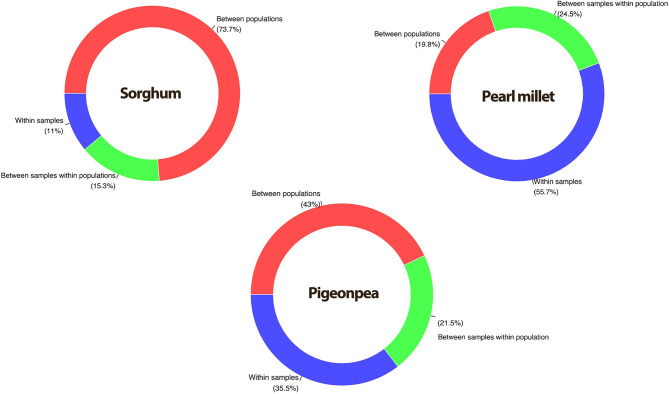
Percent contribution by different variance components in sorghum, pigeonpea, and pearl millet partitioned by AMOVA.